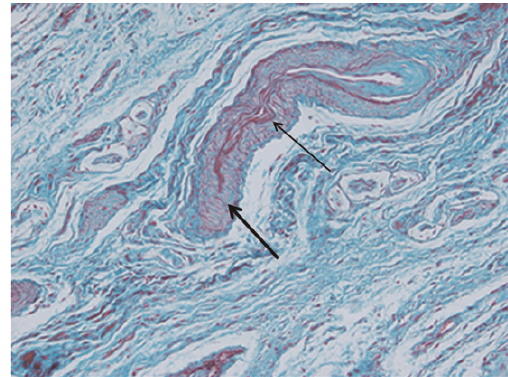
Figure 3 - Gomori trichrome stain (40 6 magnification). Neurovascular bundle presenting a thickened vascular tunica intima (thin black arrow), duplication of elastic fibers (thick black arrow) and